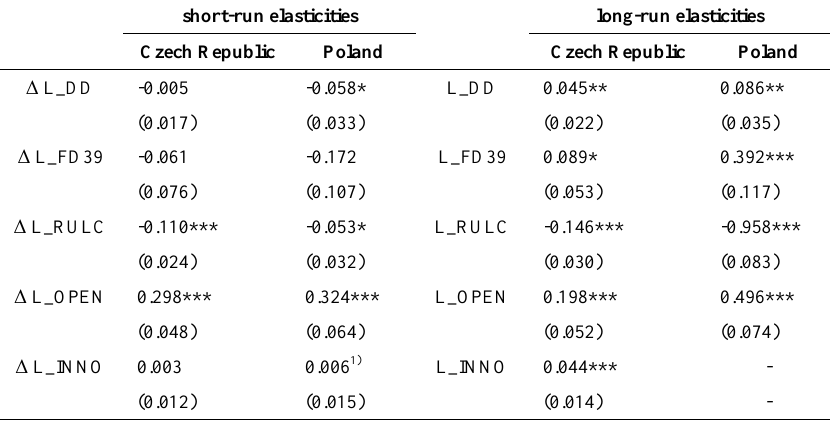
Table 2. Czech and Polish shared model – ECM